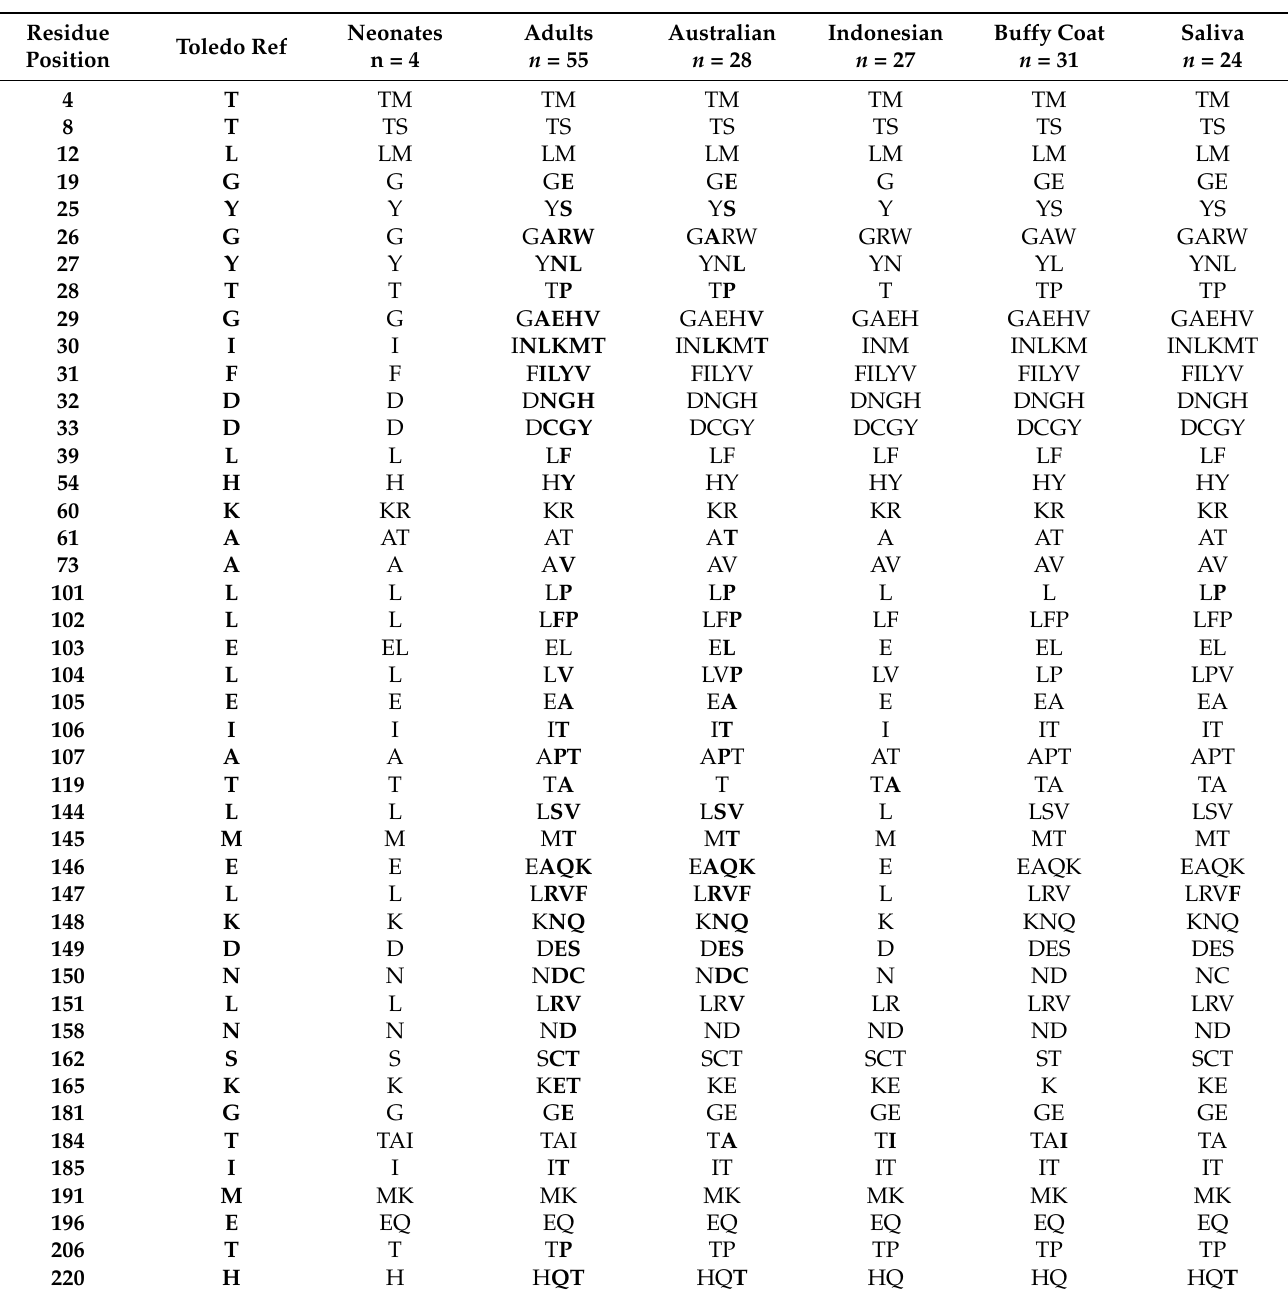
Table 1. UL18 protein variants distinct from Toledo were found in all